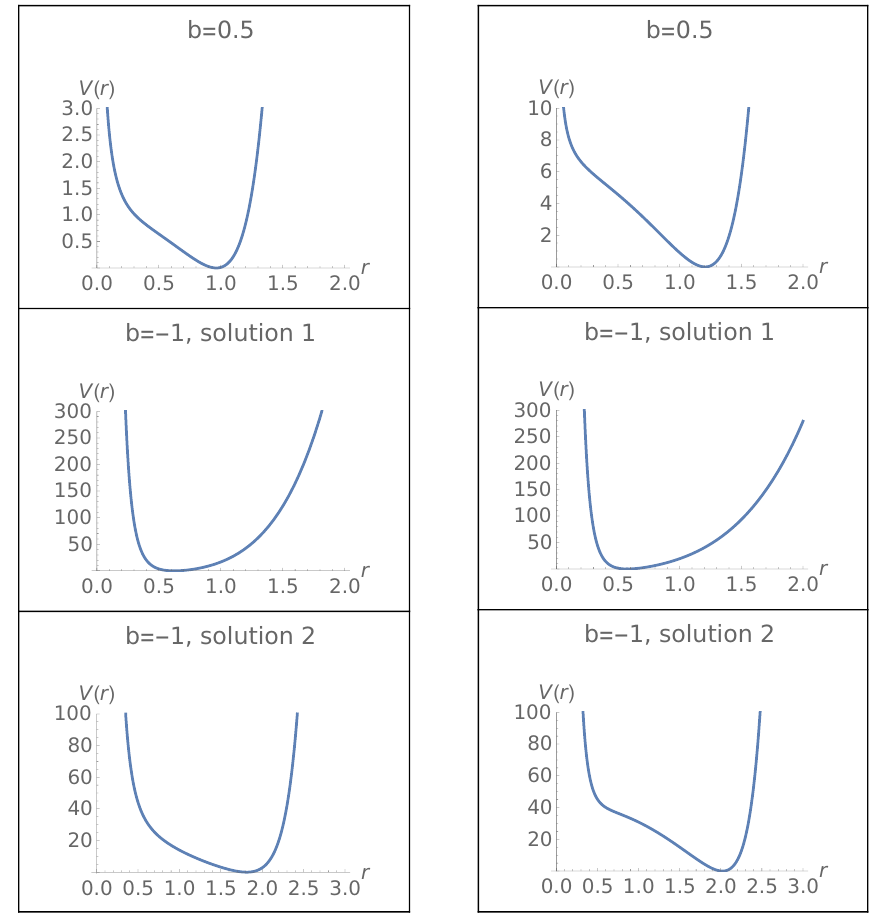
Figure 1 . Scalar potential for the model with Kähler potential K ( z, ¯ z ) = z ¯ z , superpotential W ( z ) = z b , a standard FI term ξ s , and either the original (left) or the Kähler invariant (right) new FI term with parameter ξ and values of the parameters for which (3.11), (3.12) and (3.14) are n